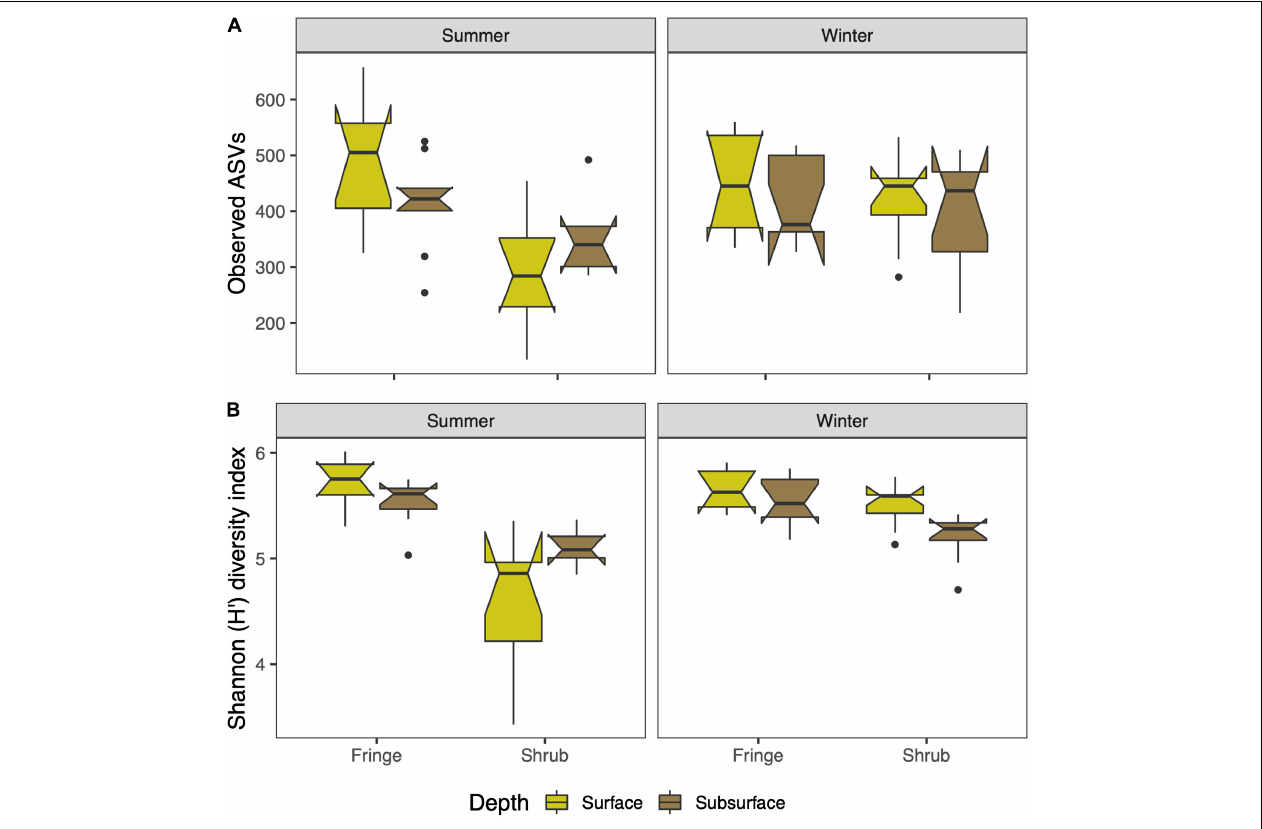
FIGURE 2 | Alpha diversity metrics of the bacterial community of arid mangrove forest soils in the Red Sea. The panels are split by season and display the zones and depths (color). (A) Species richness presented as the number of observed ASVs, and (B) species diversity calculated using the Shannon diversity index. The boxplots indicate the median with the interquartile range (IQR) between the 25th and the 75th percentile and the whiskers extend 1.5*IQR. Boxes were plotted with the notch ( ± 1.58*IQR/sqrt[n]) to display likely statistical significance if notches do not